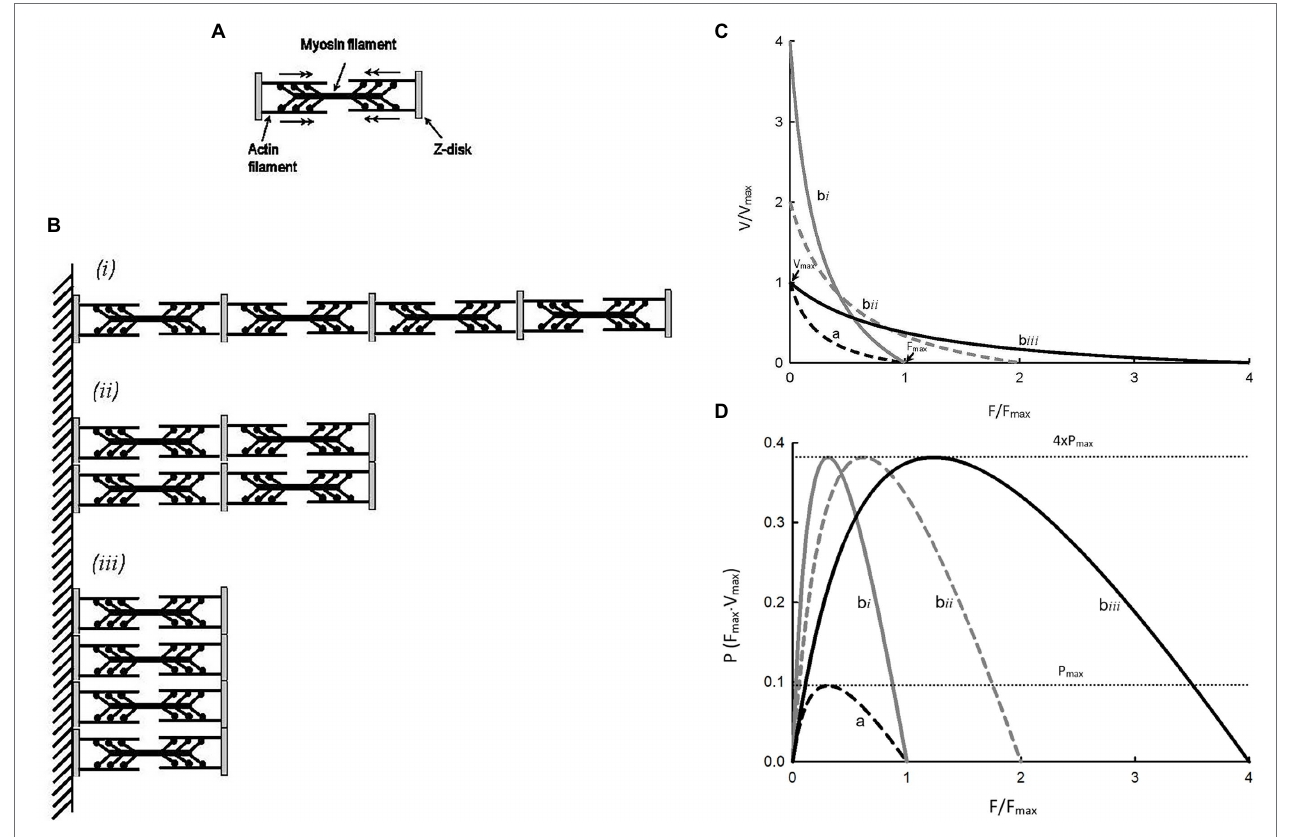
FIGURE 4 | (A) Schematic representation of a sarcomere. (B) Three different arrangements of 4 identical sarcomeres in parallel and in series. (C) Force–velocity curves for a single sarcomere (a) and each of the sarcomere arrangements ( b i , b ii , b iii ). (D) Force–power curves for a single sarcomere (a) and each of the sarcomere arrangements ( b i , b ii , b iii